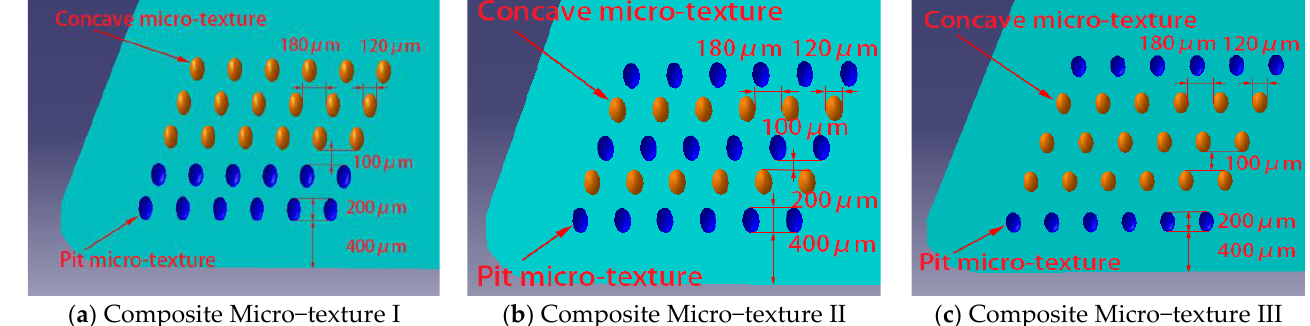
Figure 6. Micro−texture simulation mode.